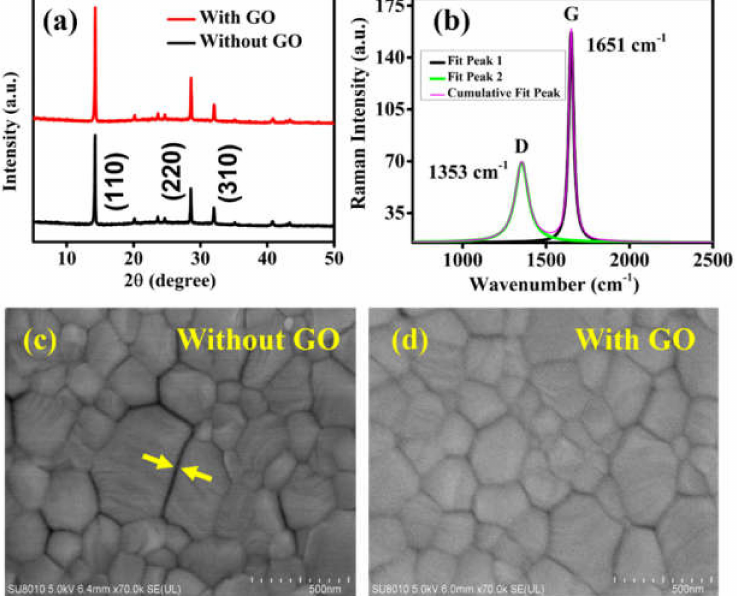
Figure 2. ( a ) XRD spectra of perovskite films with and without graphene oxide, and ( b ) Raman spectrum of the GO. The Raman spectrum fitted with Lorentz function, having typical D and G bands that are associated with graphite material. FE-SEM micrograph of the perovskite films ( c ) without GO interlayer having wide gaps, and ( d ) with GO interlayer having narrow and comparatively fewer